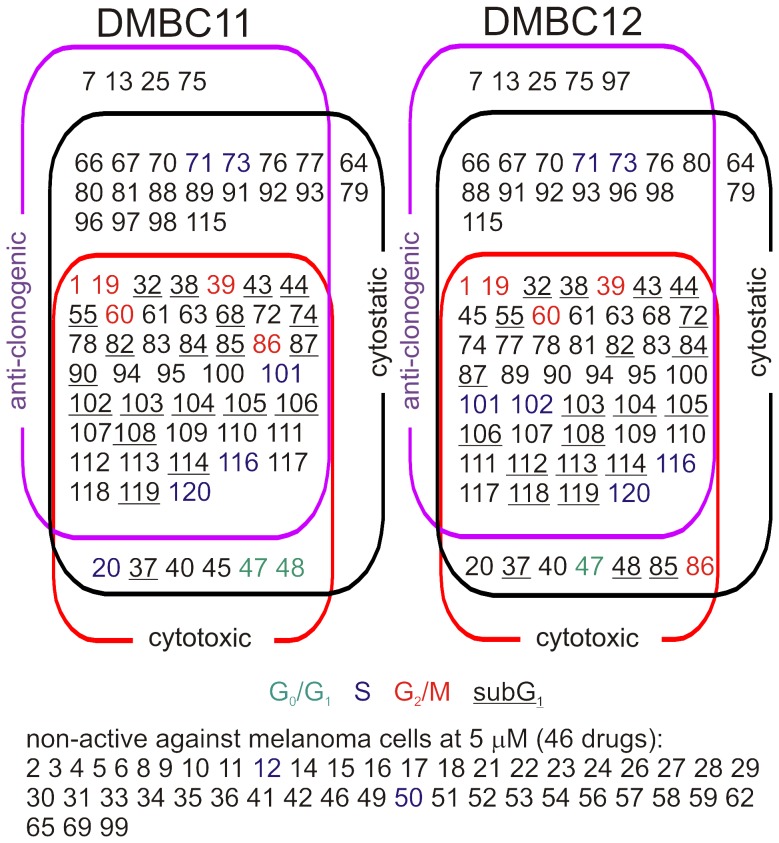
The summary of natural compound activities at 5 µM.After initial screening, compounds were grouped based on their activities. A compound was defined as anti-clonogenic when it reduced the percentage of clones formed in soft agar to less than 20% of control treated with vehicle (0.05% DMSO). A compound was named cytostatic when it reduced the viable cell number to less than 50% of control using viable cell number counting, and cytotoxic using the flow cytometry after PI-staining. Numbers corresponding to compounds that accumulated melanoma cells in subG1 are underlined. Compounds that caused cell cycle arrest are marked in green for G0/G1 phase, blue for S phase and red for G2/M phase. Several compounds (46) were not active in any assay. Few compounds were cytotoxic but not markedly influenced the numbers of colonies formed in agar. Few other compounds exerted their effects only on clonogenic cells or reduced clonogenicity below 20% of control, caused cytostatic/cytostatic effect without inducing substantial cell death. Several compounds were cytostatic and cytotoxic and in addition they efficiently eradicated cells with clonogenic potential. They were in the focus of the further study. See Table S1 in File SI for the names of the compounds corresponding to numbers shown in the Figure.